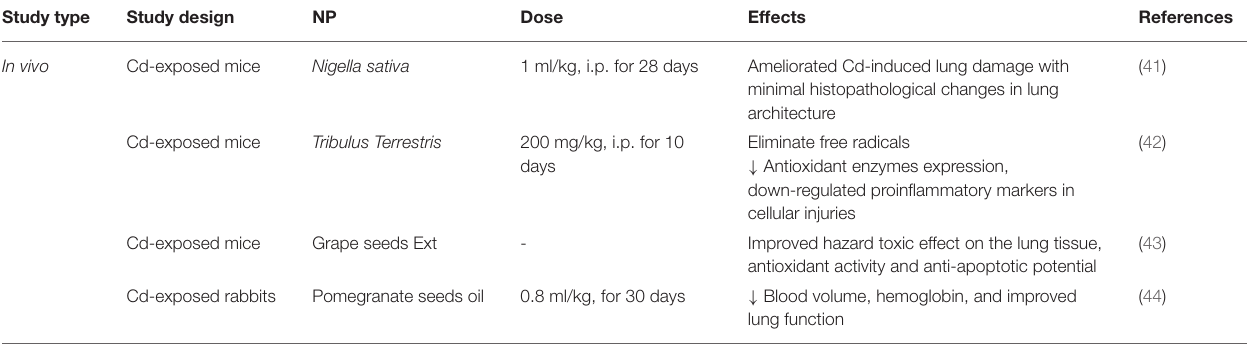
TABLE 2 | The possible therapeutic effects of NP in the Cd-induced lung injury.